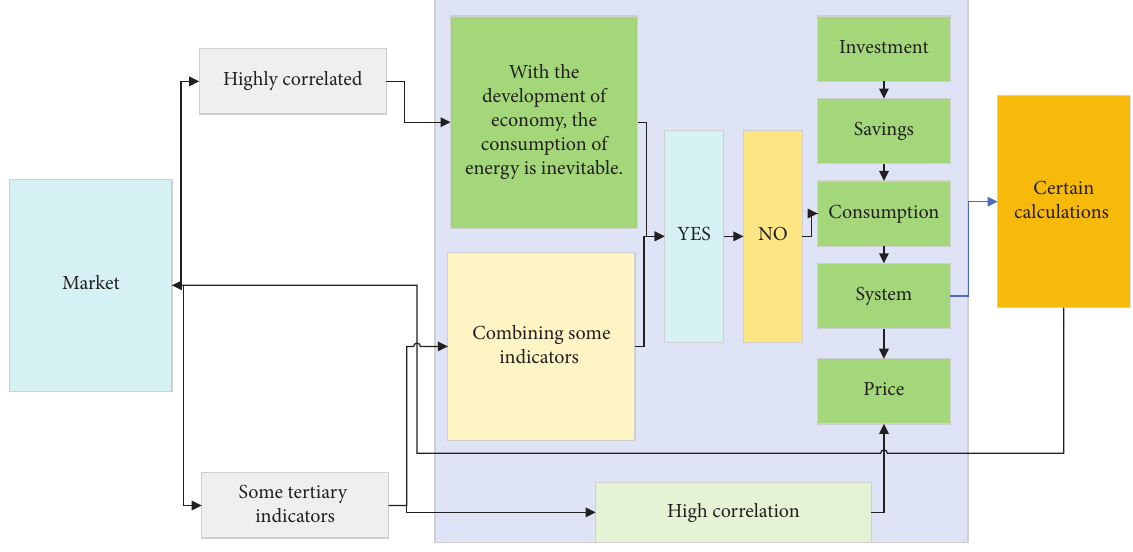
Figure 4: Market indicator